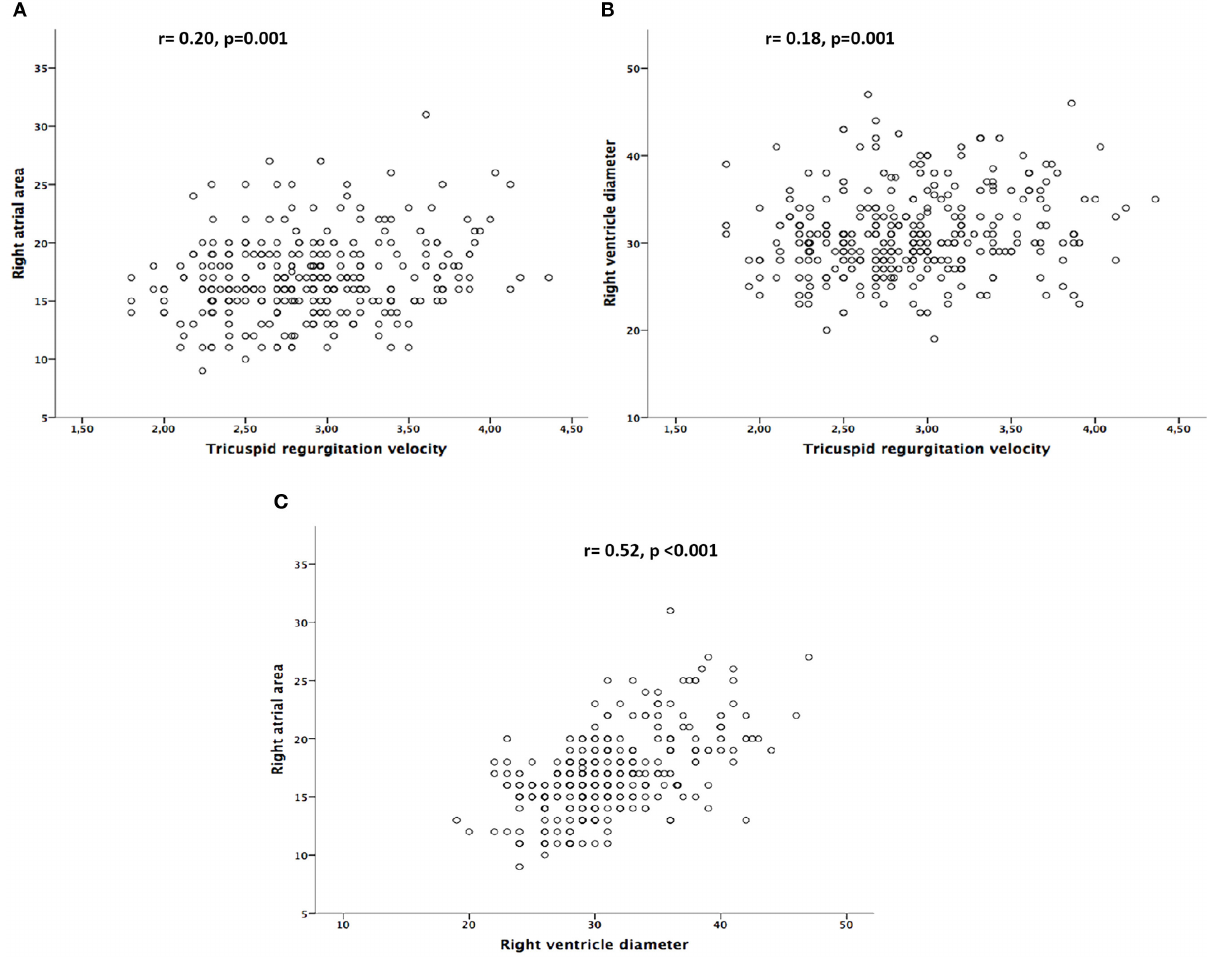
FIGURE 3 | (A) Correlation between tricuspid regurgitation velocity and right atrial area. (B) Correlation between tricuspid regurgitation velocity and right ventricle diameter. (C) Correlation between right atrial area and right ventricle